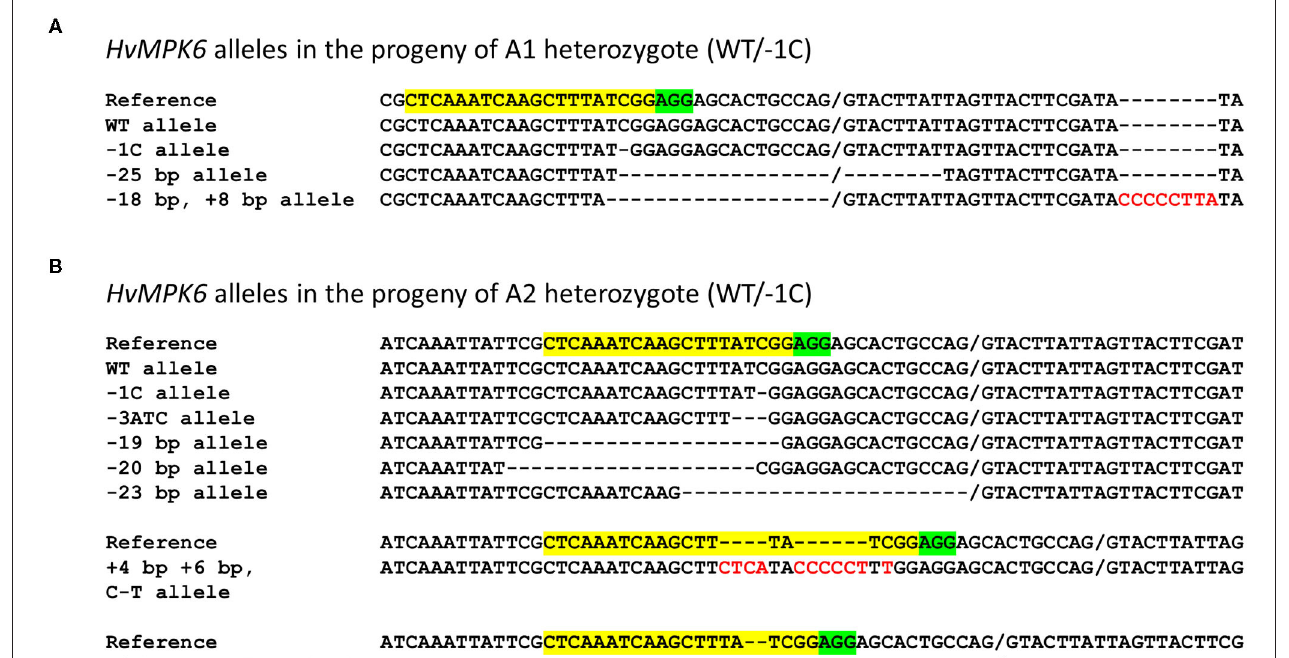
Frontiers in Plant Science |